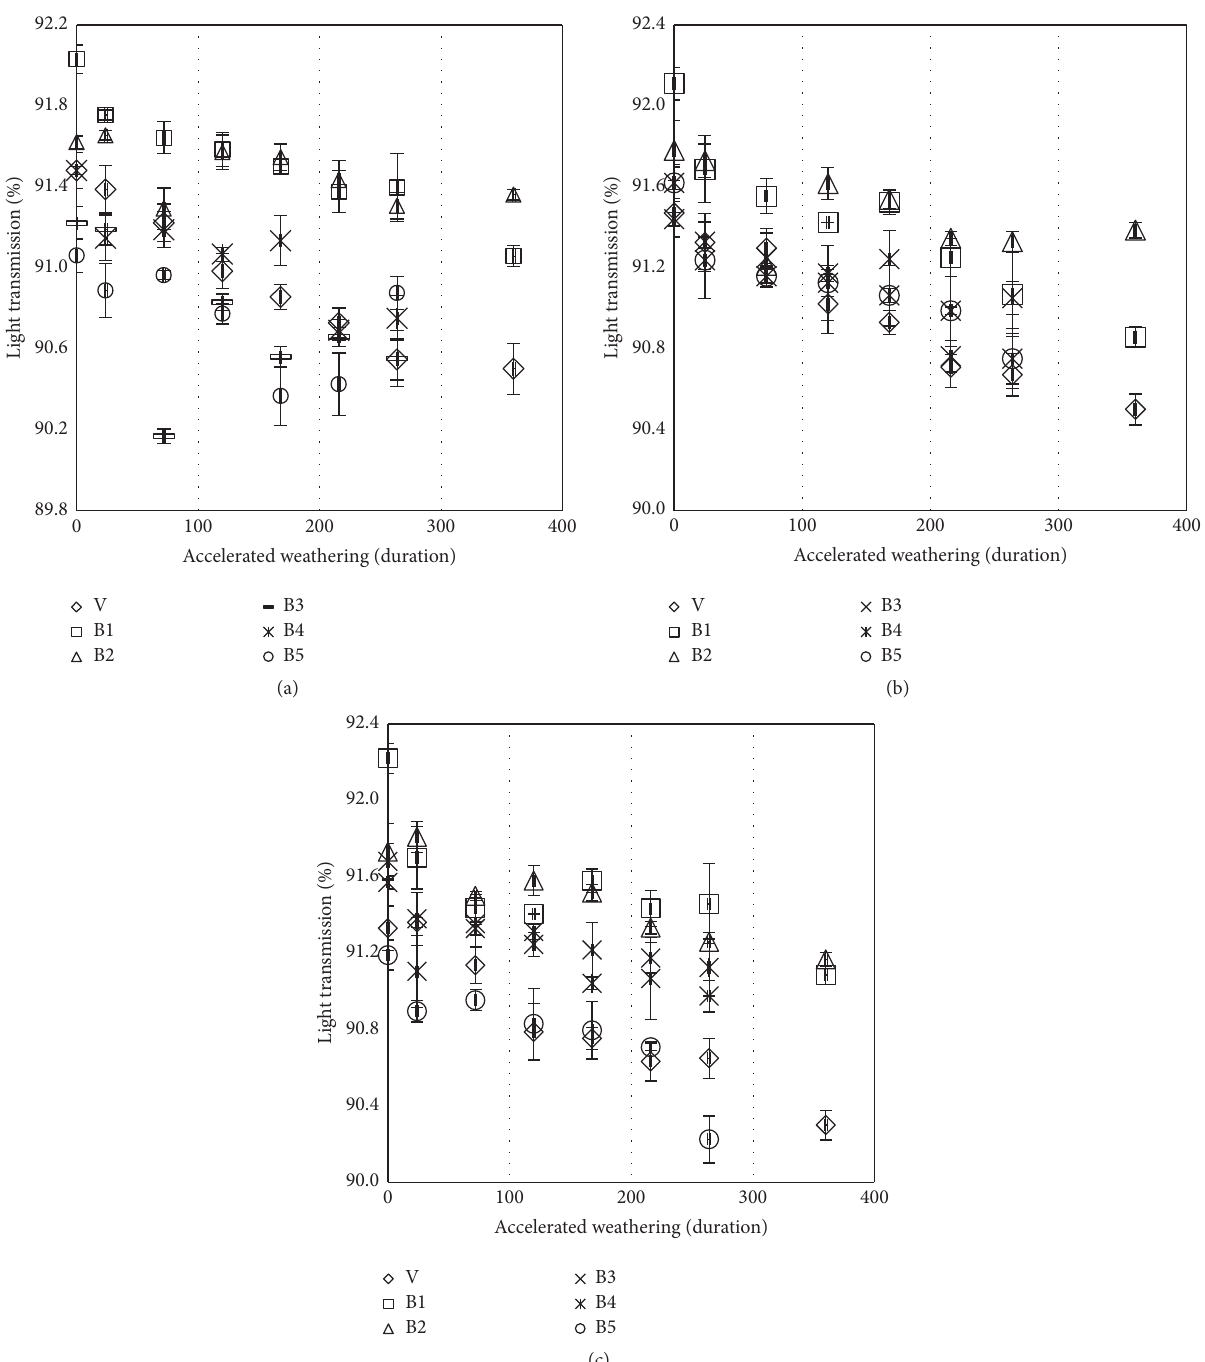
Figure 7: Light transmission (%) of the formulated samples with respect to accelerated weathering duration (days). Samples processed with a Die Head Temperature (DHT) = 175, 185, and 195 ∘ C are shown in (a), (b), and (c), respectively.